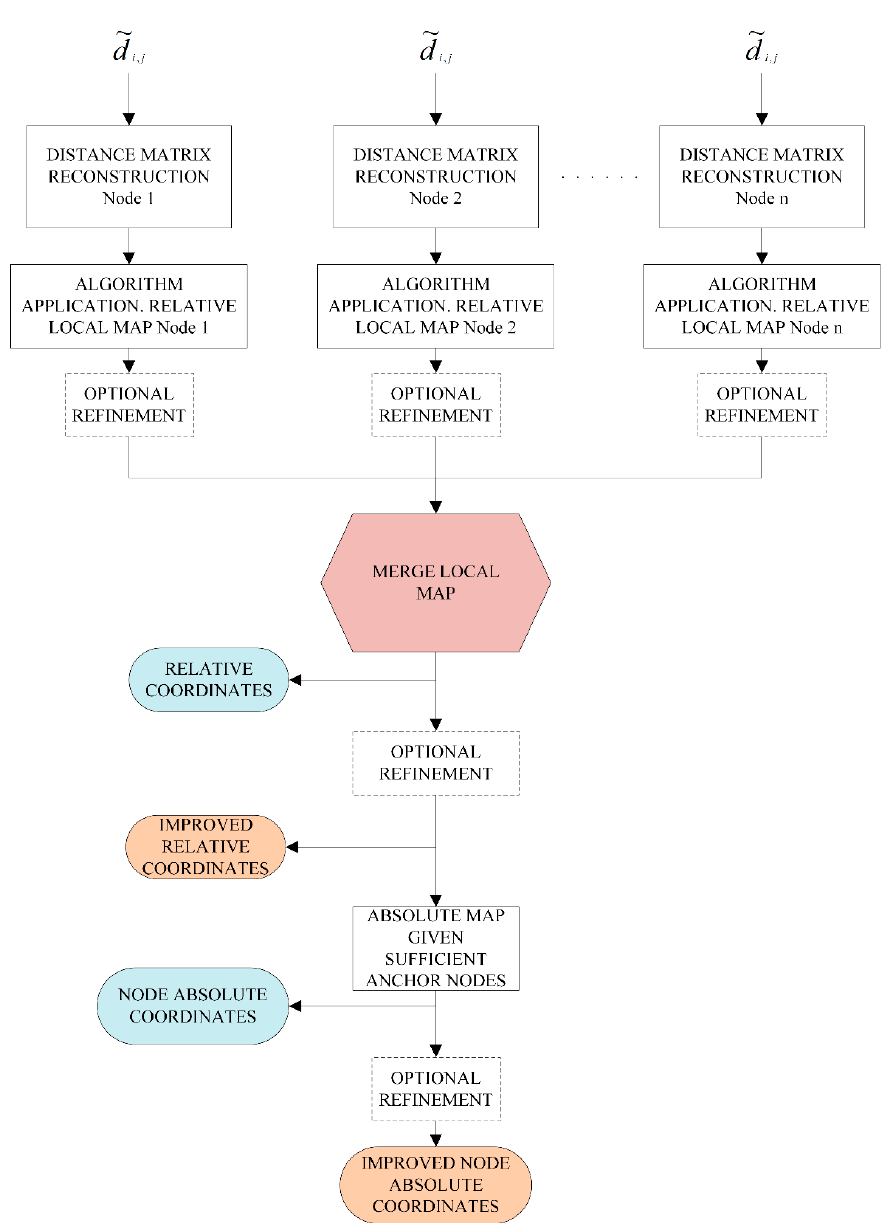
Figure 2. General cooperative localization steps.